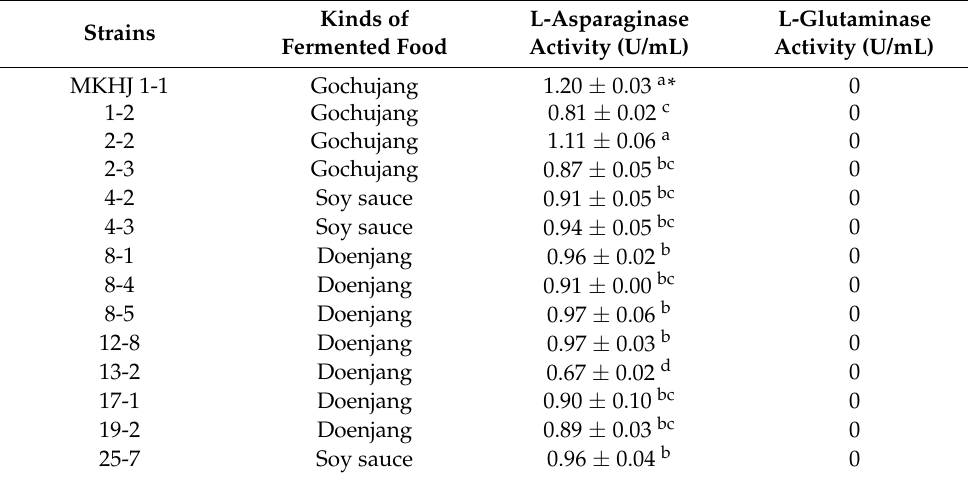
Table 1. L-asparaginase and L-glutaminase activity of selected strains. Kinds of Strains Fermented Food